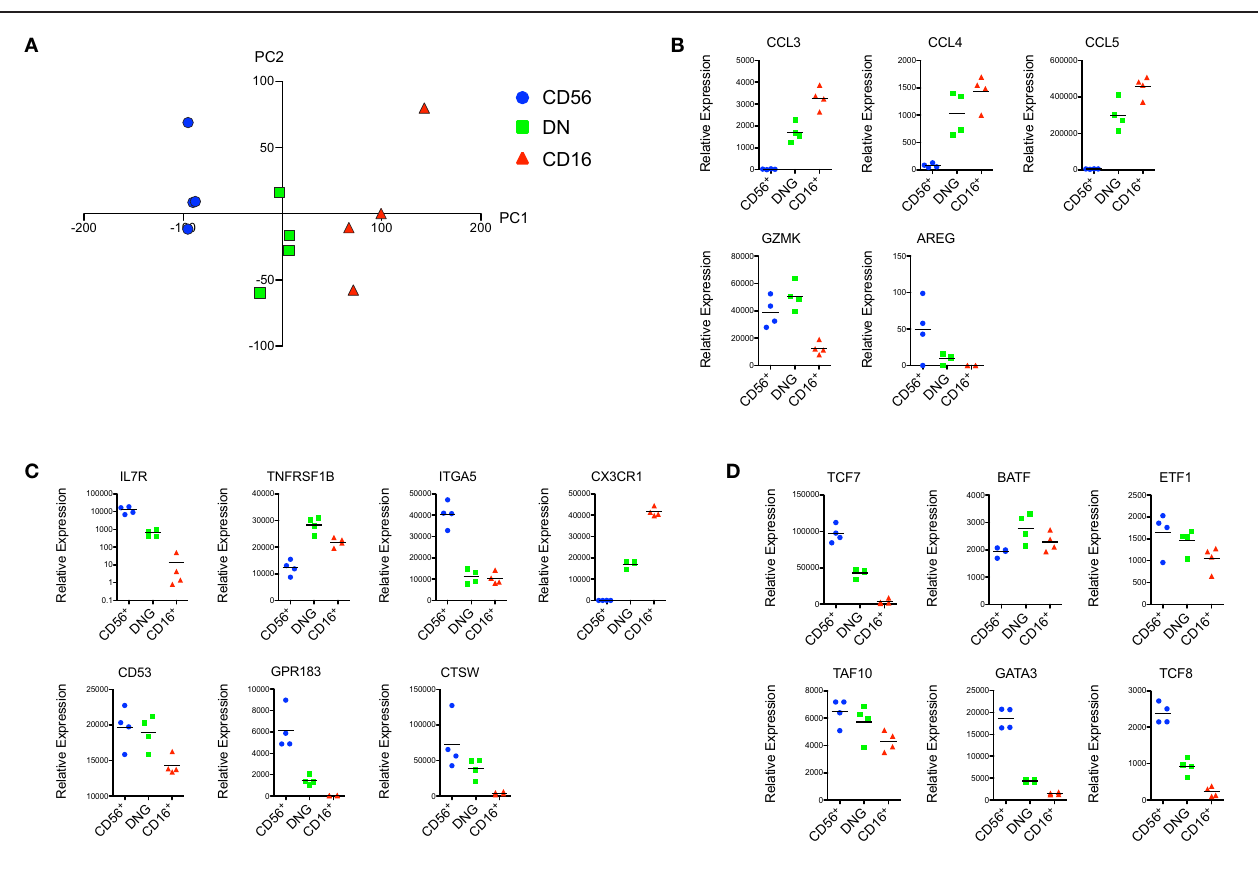
(horizontal) andPC2(vertical) axesareshown. (B–D) RelativemRNAexpression of genes encoding for effector proteins (B) , cell surface receptors and proteins (C) and proteins associated with transcriptional control (D) are shown.